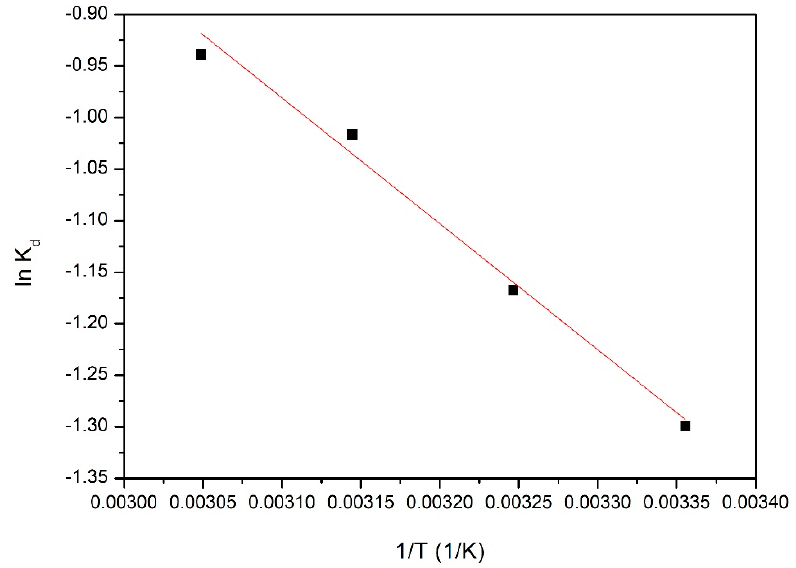
Figure 10. Plot of ln K d vs 1/T for the estimation of thermodynamic parameters for Pd(II) recovery on XAD7-DB18C6. Table 4. Thermodynamic parameters for adsorption of Pd(II) onto XAD7-DB18C6.